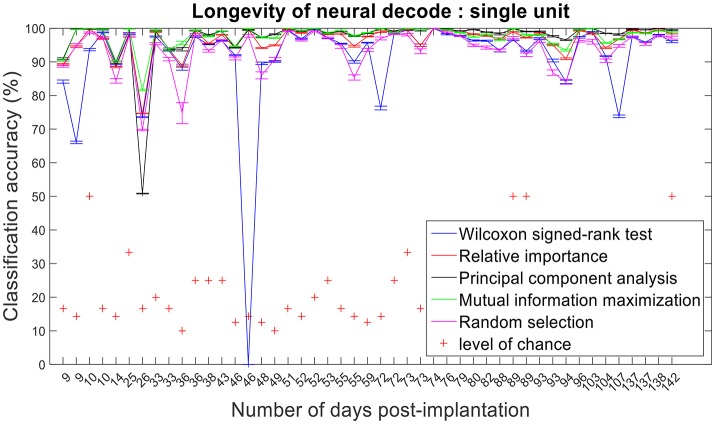
Longevity of neural decodes using single-unit firing rate. The optimal number of features for each feature selection technique was identified using an iterative cross validation scheme. For a given day, cross validation and performance evaluation were computed as described in section Performance Metrics.